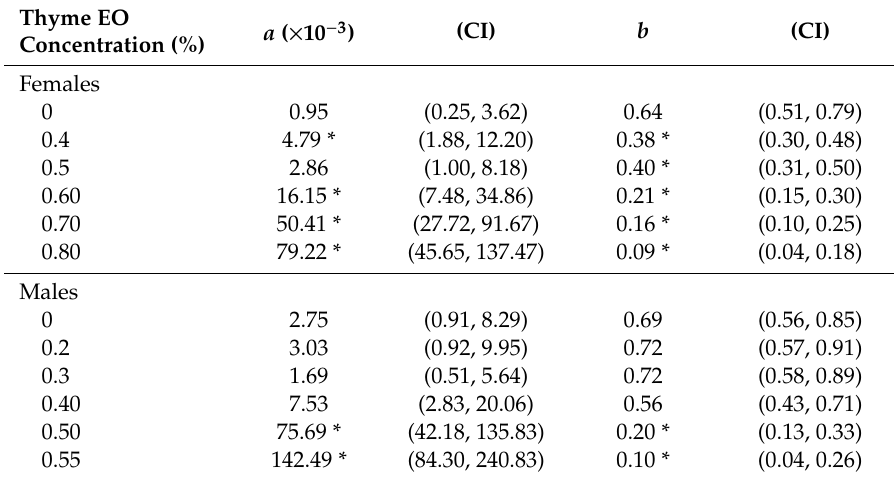
Table 2. E ff ects of di ff erent concentrations of thyme essential oil (EO) on Gompertz mortality parameters a and b . Baseline mortality ( a ) and exponential increase in mortality with age ( b ) are presented with 95% confidence intervals (CI). Significant di ff erences from the control group are marked with asterisks (log-likelihood ratio test, df = 1, p <